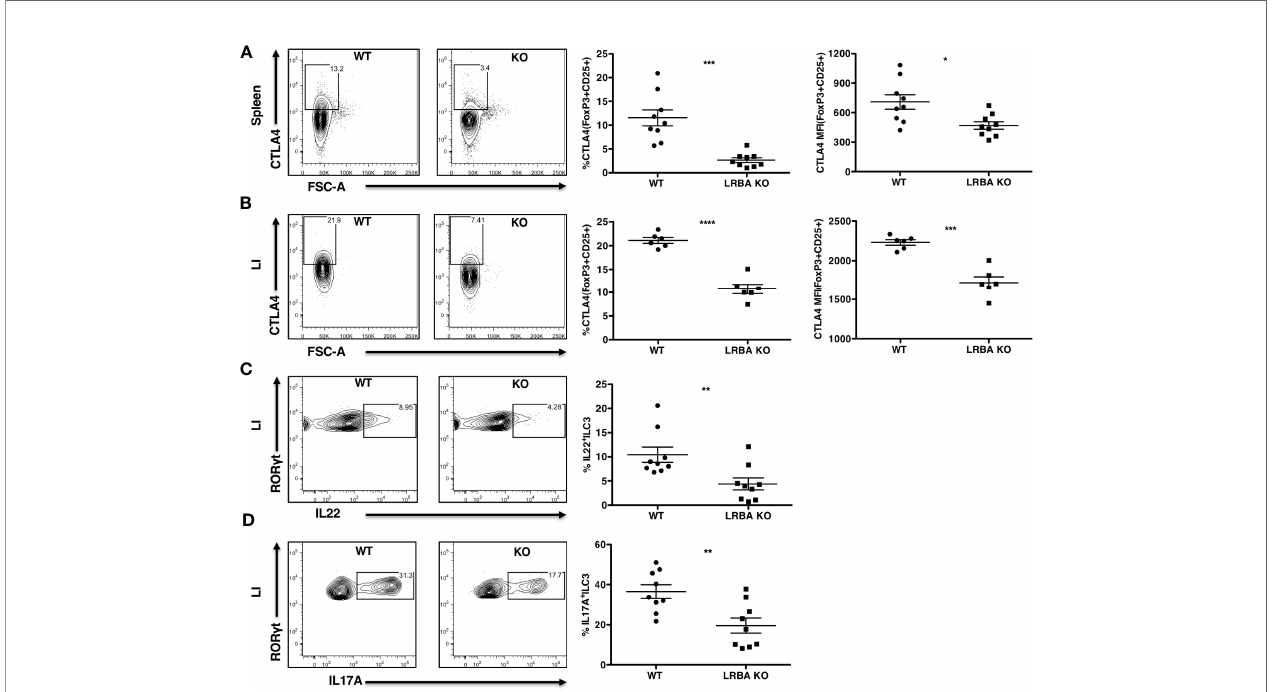
FIGURE 4 | LRBA KO mice show reduced CTLA4 expression on Treg cells and impaired ILC3 effector function following colonic stress. WT and LRBA KO mice received 3% DSS in drinking water for 5 days and were analyzed for intracellular CTLA4 expression and IL22 and IL17A production by ILC3. (A) Contour plots and scatter plots showing CTLA4 expression on splenic FoxP3 + CD25 + Treg cells after gating on viable CD3 + CD4 + cells. (B) Plots showing CTLA4 expression on LI lamina propria FoxP3 + CD25 + Treg cells gated on viable CD3 + CD4 + cells. Plots showing the frequency of IL22 + ROR g t + (C) and IL17A + ROR g t + ILC3 (D) after gating on viable Lin − CD45 + Thy1.2 + IL7R a + ROR g t + cells in the LI lamina propria. Data pooled from 3 independent experiments (A, C, D) , n = 9 per genotype. (B) Pooled from 2 independent experiments, n = 6 per genotype. *p < 0.05, **p < 0.01, ***p < 0.001, ****p < 0.0001. KO, knockout; WT, wild type; DSS, dextran sulfate sodium; LI, large